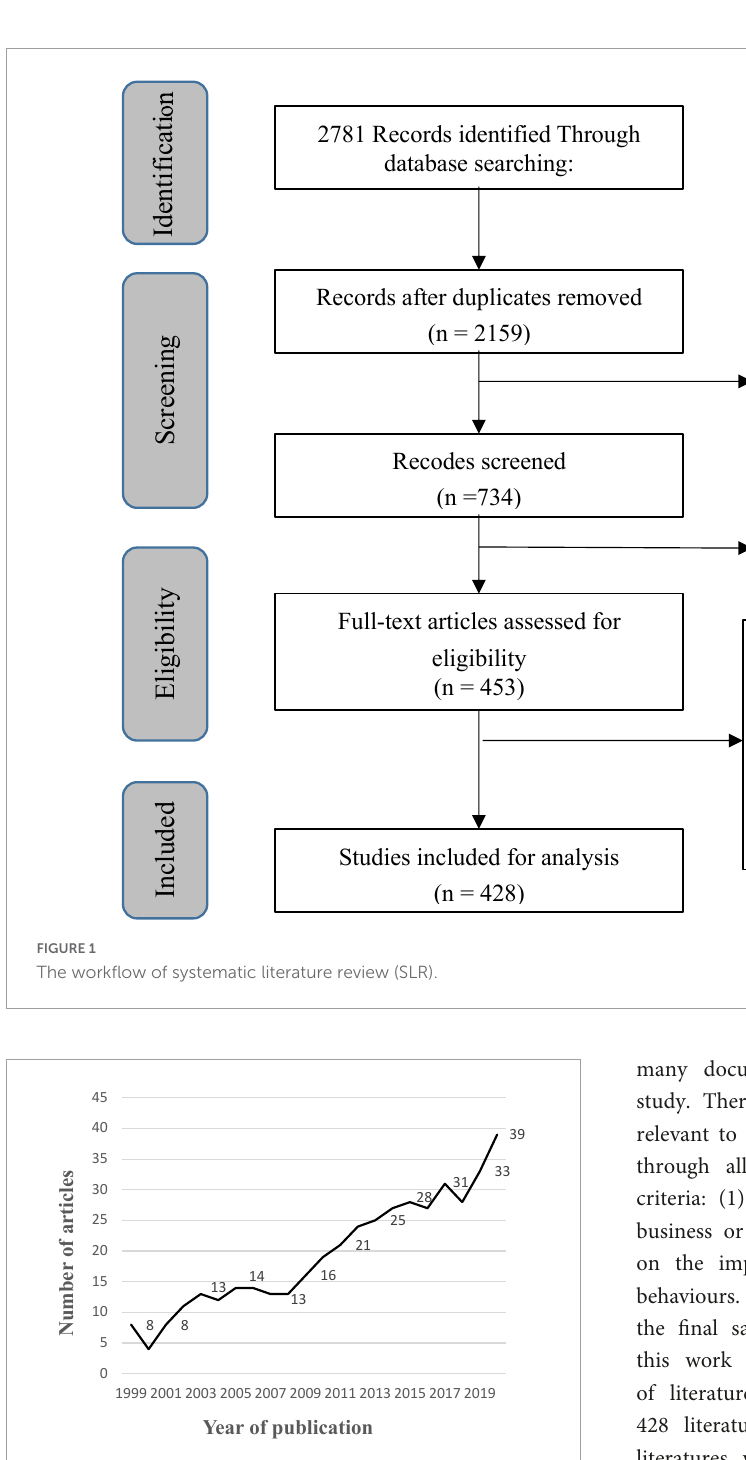
FIGURE2 Distribution of literature published over time.